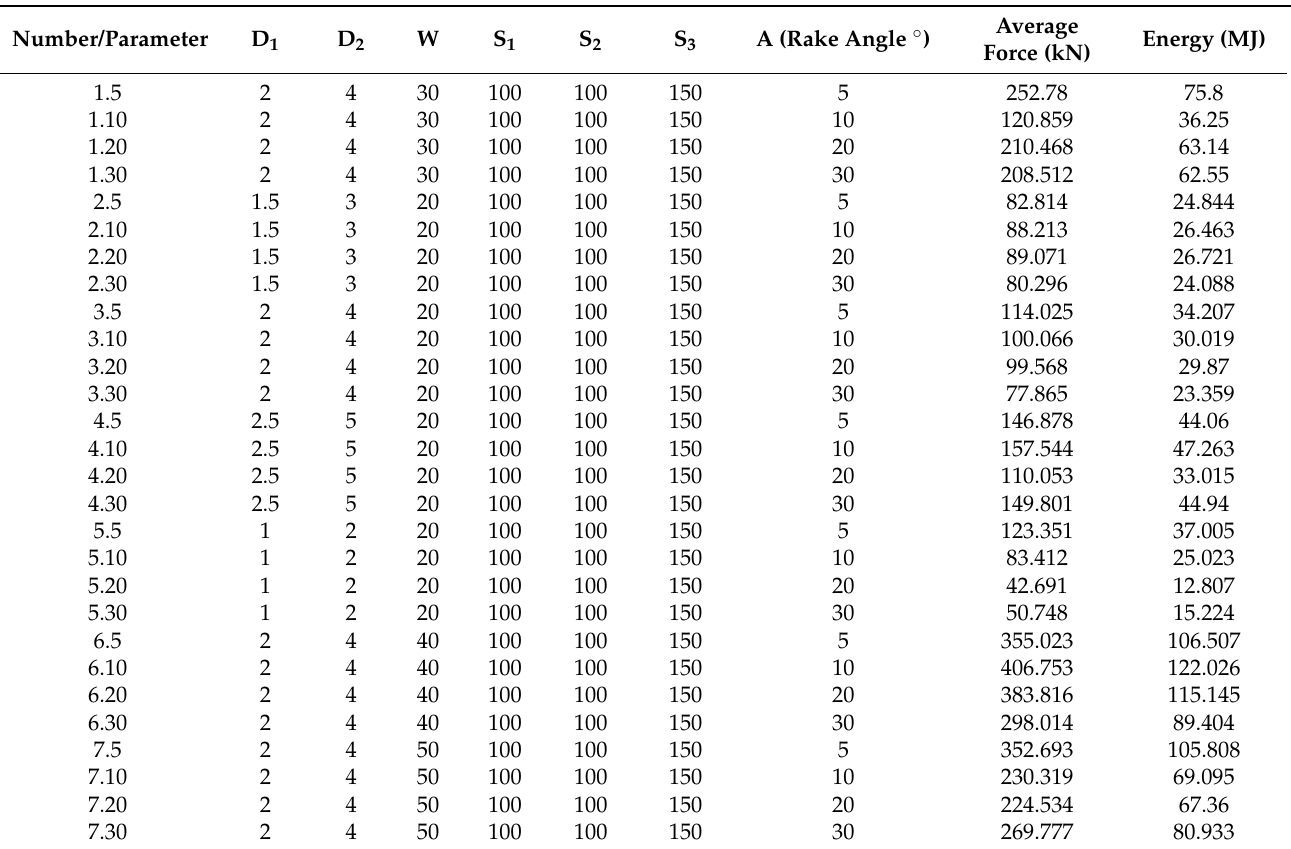
Table 2. Simulation parameters and